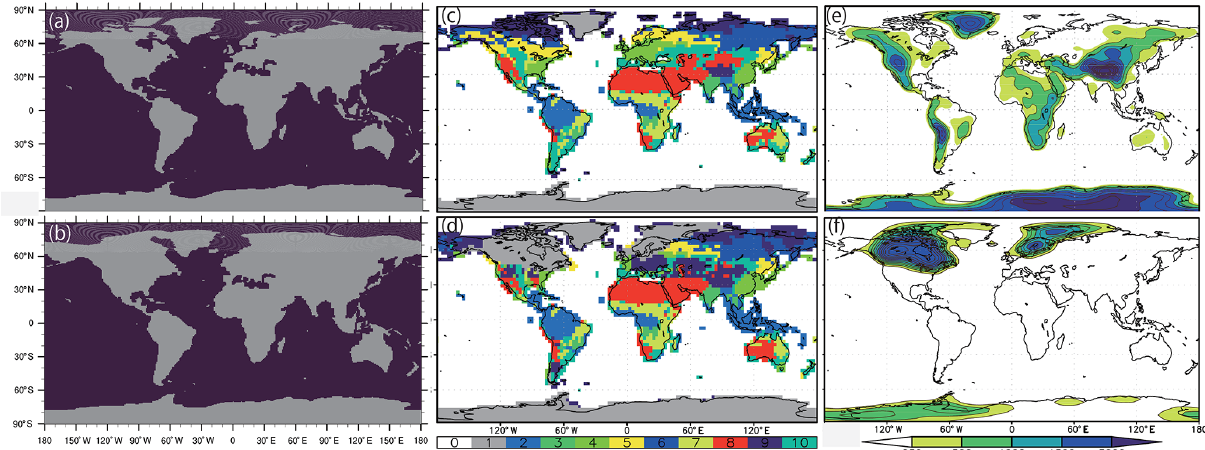
Figure 2. (a, b) Land–sea distribution converted to 1 ◦ × 1 ◦ ocean grids for (a) PI, 6ka, and 127ka and (b) LGM. (c, d) Distribution of land vegetation types for (c) PI, 6ka, and 127ka and (d) LGM. Numbers in color bar represent vegetation types: (1) ice sheets, (2) broadleaf ever- green forest, (3) broadleaf deciduous forest and woodland, (4) mixed coniferous and broadleaf deciduous forest and woodland, (5) coniferous forest and woodland, (6) high-latitude deciduous forest and woodland, (7) wooded C 4 grassland, (8) shrubs and bare ground, (9) tundra, and (10) C 3 grassland. (e) Altitude for PI, 6ka, and 127ka and LM (unit: m) and (f) altitude anomaly (unit: m) given for the LGM experiment based on ICE-6G_C (Peltier et al., 2015).